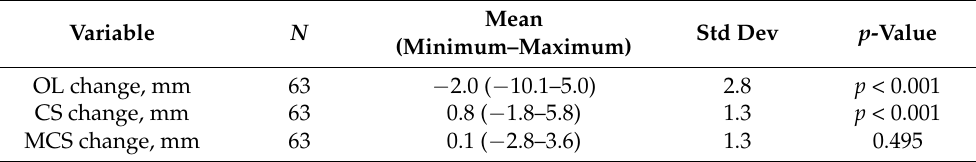
Table 2. Differences in radiographic outcomes for the total observation period.